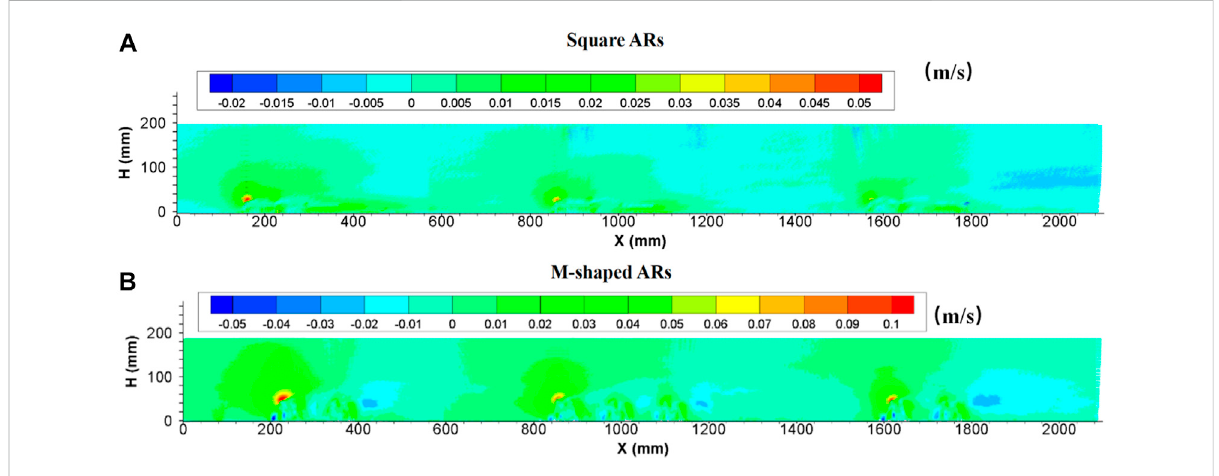
FIGURE 6 Side view of vertical velocity fi eld following the presence of square ARs (A) and M-shaped ARs (B) under the same experimental